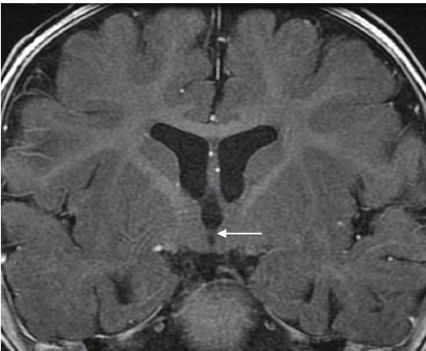
Figure 3: Postcontrast coronal FSPGR T1WI (repetition time msec/echo time msec/inversion time msec, 19/9/375) depicting a parenchymalbandthatisisointensetograymattercrossingthethird ventricle and connecting the medial hypothalami